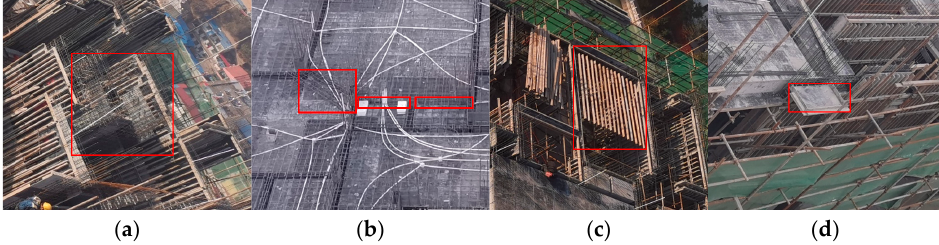
Figure 10. Detection error cases: ( a ) Not detected due to occlusion; ( b ) Not detected as the feature is